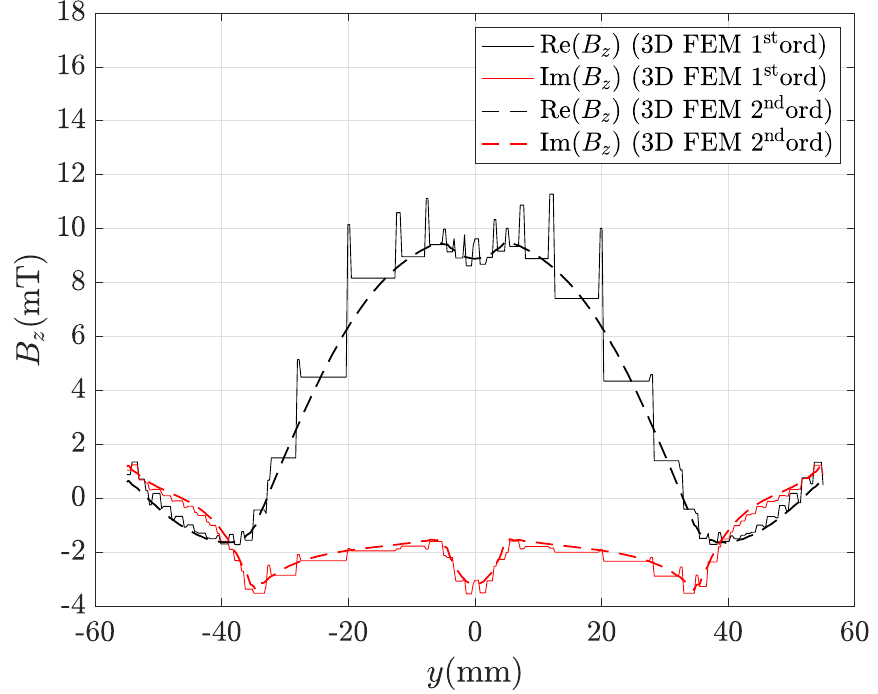
Figure 22. Real and imaginary parts of the magnetic flux density radial component B z along line AB depicted in Figure 8 computed by FEM with the coarsest mesh (69,702 tets for plate, 1,171,167 tets for air): first ord. 3D FEM is the straight line, second ord. 3D FEM (reference) is the dashed